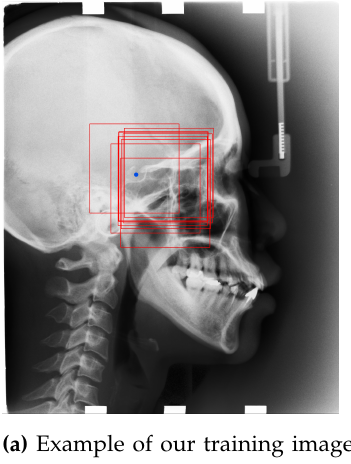
the red boxes are cropped training images. Figure 3. The way we crop ROI patches for each landmark: the blue dot is a target landmark, the red boxes are extracted 512 × 512 ROI patches. We can see the landmark is included in all the ROI patches. We randomly extract 400 patches for one landmark in one x-ray image for training. Then we resize the ROI patches into 256 × 256 to make